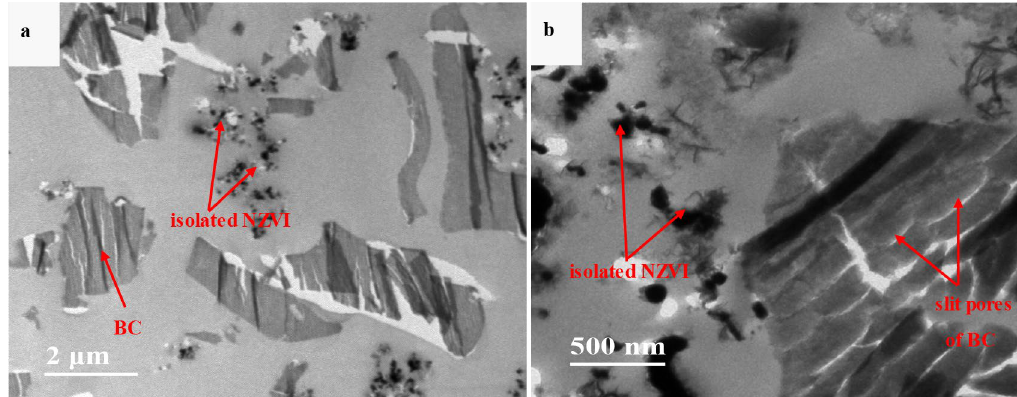
Figure 4. C-TEM images ( a , b ) of NZVI/BC.